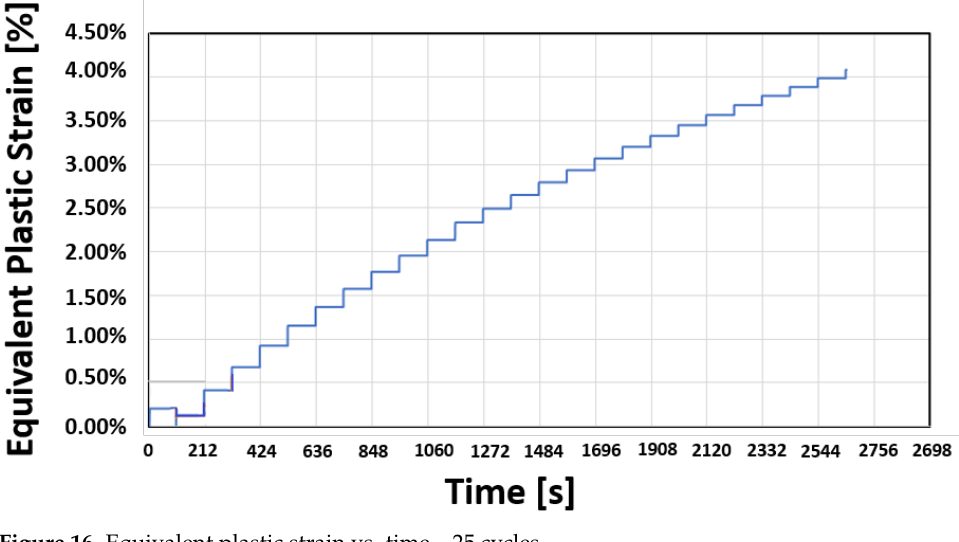
Figure 15. Equivalent plastic strain evolution with number of cycles.